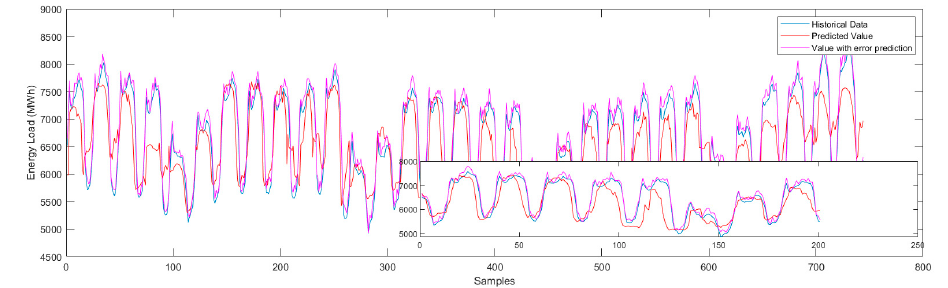
Figure 10. Validation plot for July load forecasting.